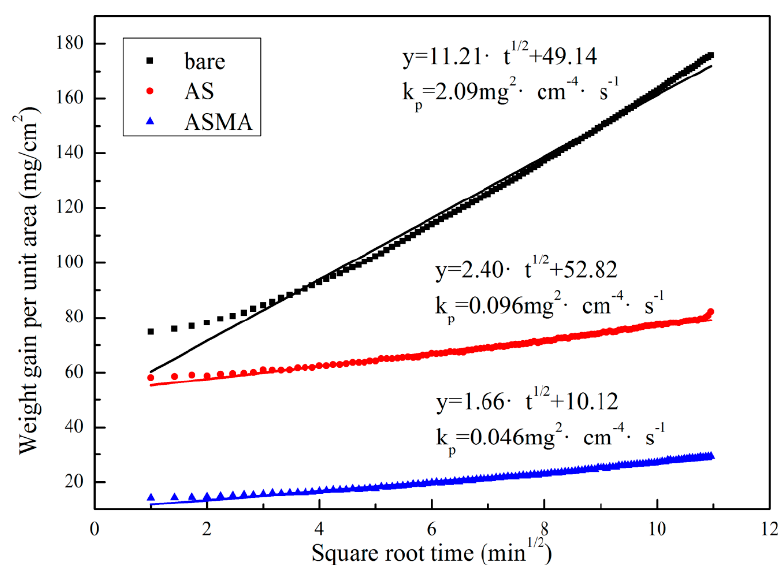
Figure 6. Results of isothermal kinetics.